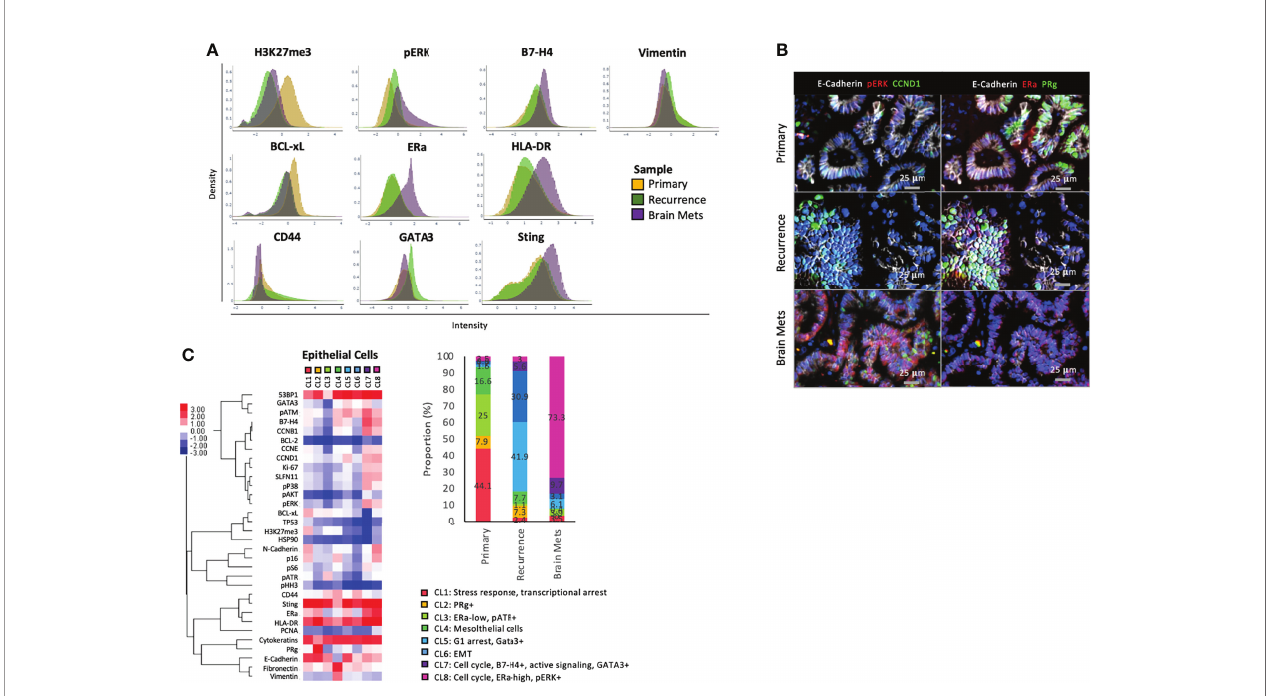
FIGURE 2 | Epithelial cell phenotype. (A) Density plot showing the distribution of expression of speci fi c markers across epithelial cells from each sample. (B) Representative immunostaining of markers that are differentially expressed across samples. (C) A K-Mean clustering was performed on epithelial cells. The heat maps represent the median expression of each marker within each cluster (CL), and the phenotype of each cluster is annotated. The histogram represents the frequency of each cluster within the samples, and the cluster phenotypes are described below the histogram. The full name of each protein can be found in Supplementary Table S1